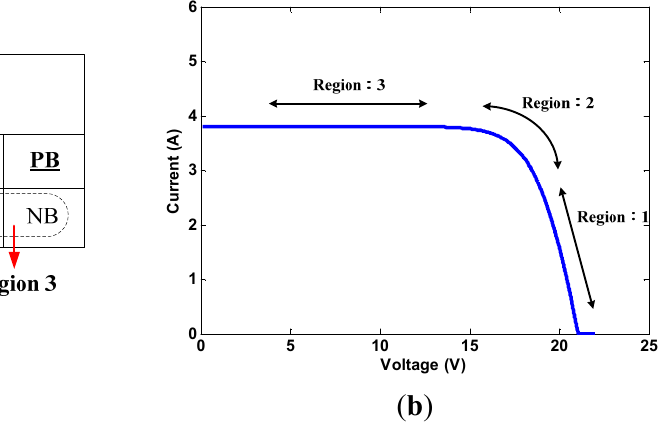
Figure 24. Fuzzy rules for Algorithm